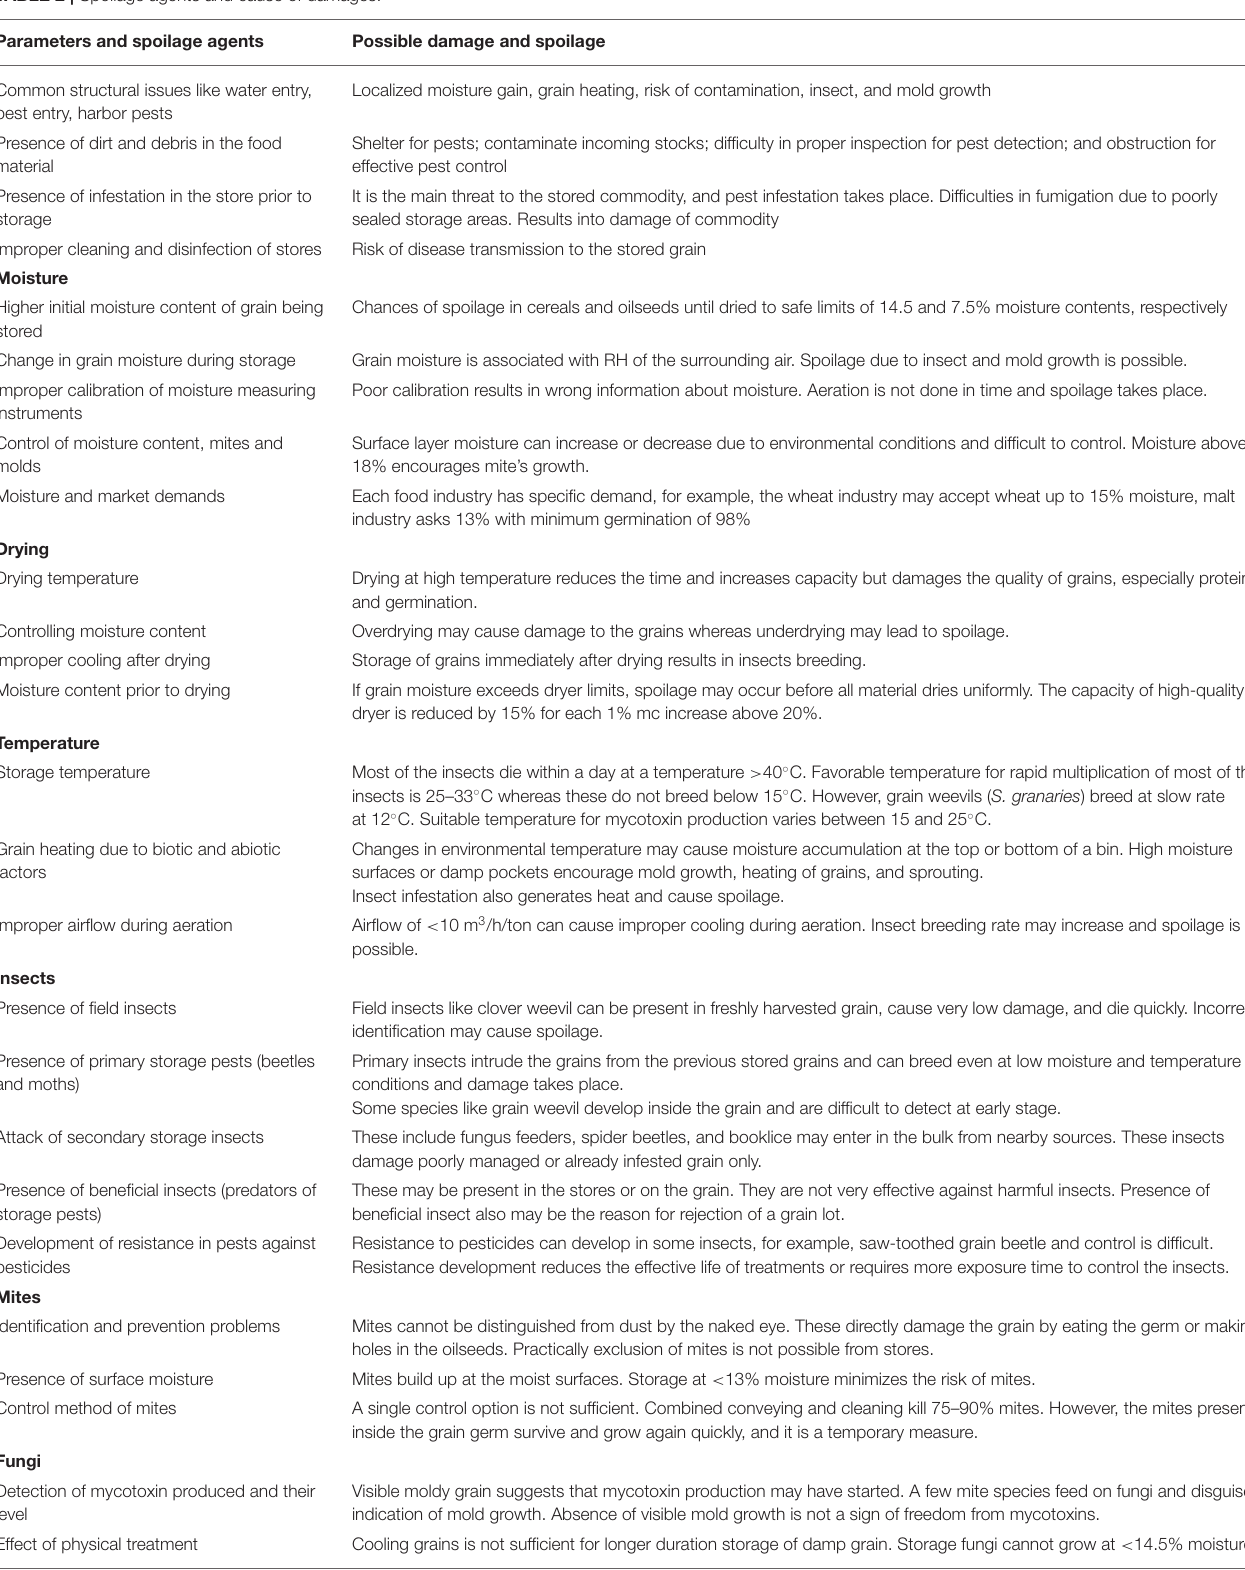
TABLE 2 | Spoilage agents and cause of